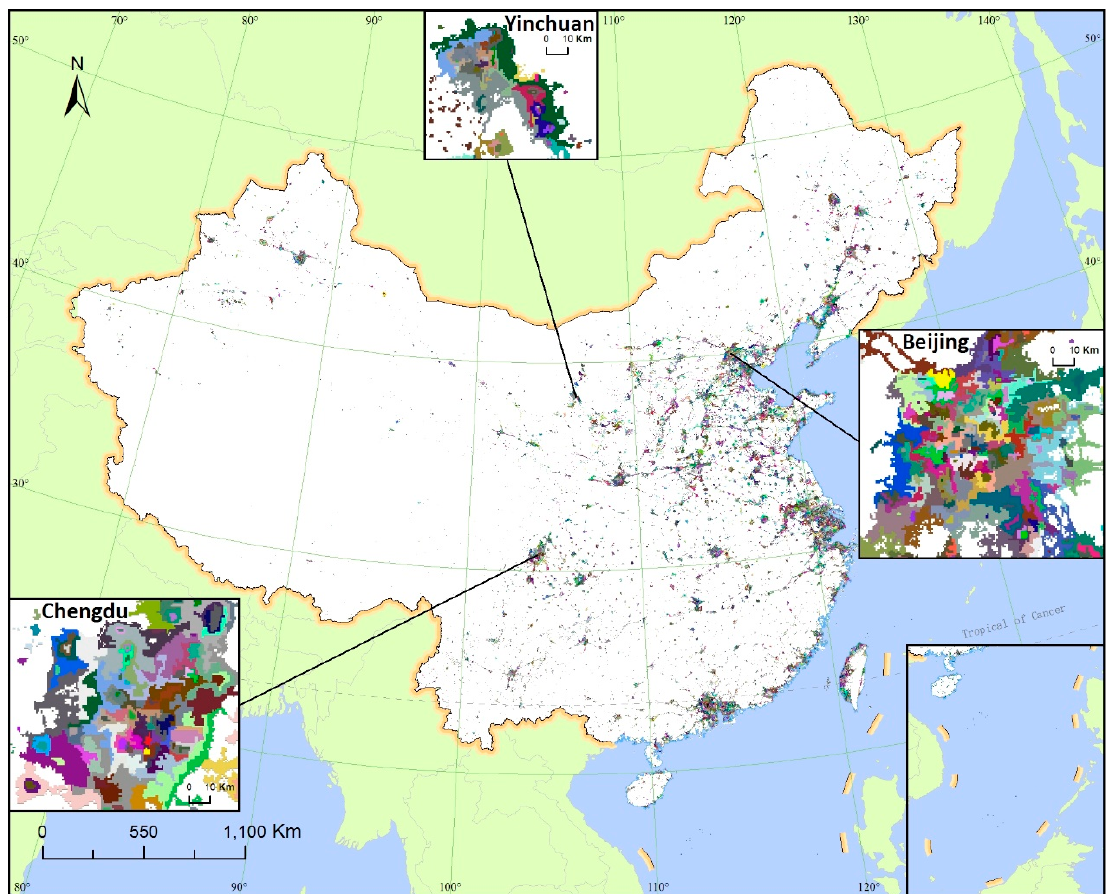
Figure 4. Potential urban objects in a VIIRS DNB image of the study area. The insets show the zoom-in for Beijing, Chengdu, and Yinchuan. Different potential urban objects are identified by different non-white colors. The white background corresponds to non-urban area.